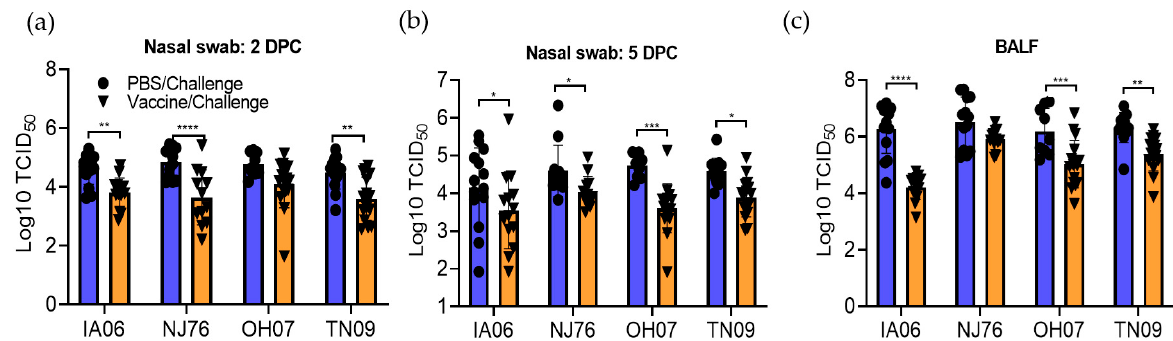
Figure 6. Viral load in piglets after challenge with influenza viruses. Influenza virus titers in nasal swab at 2 DPC ( a ), 5 DPC ( b ), and BALF ( c ) were determined by quantitative RT-PCR. Black circle and triangle represent PBS/challenge and vaccine/challenge groups, respectively. Statistical analysis for comparison between each challenge group was performed by one-way ANOVA. *, p < 0.05; **, p < 0.01; ***, p < 0.001, ****, p < 0.0001.